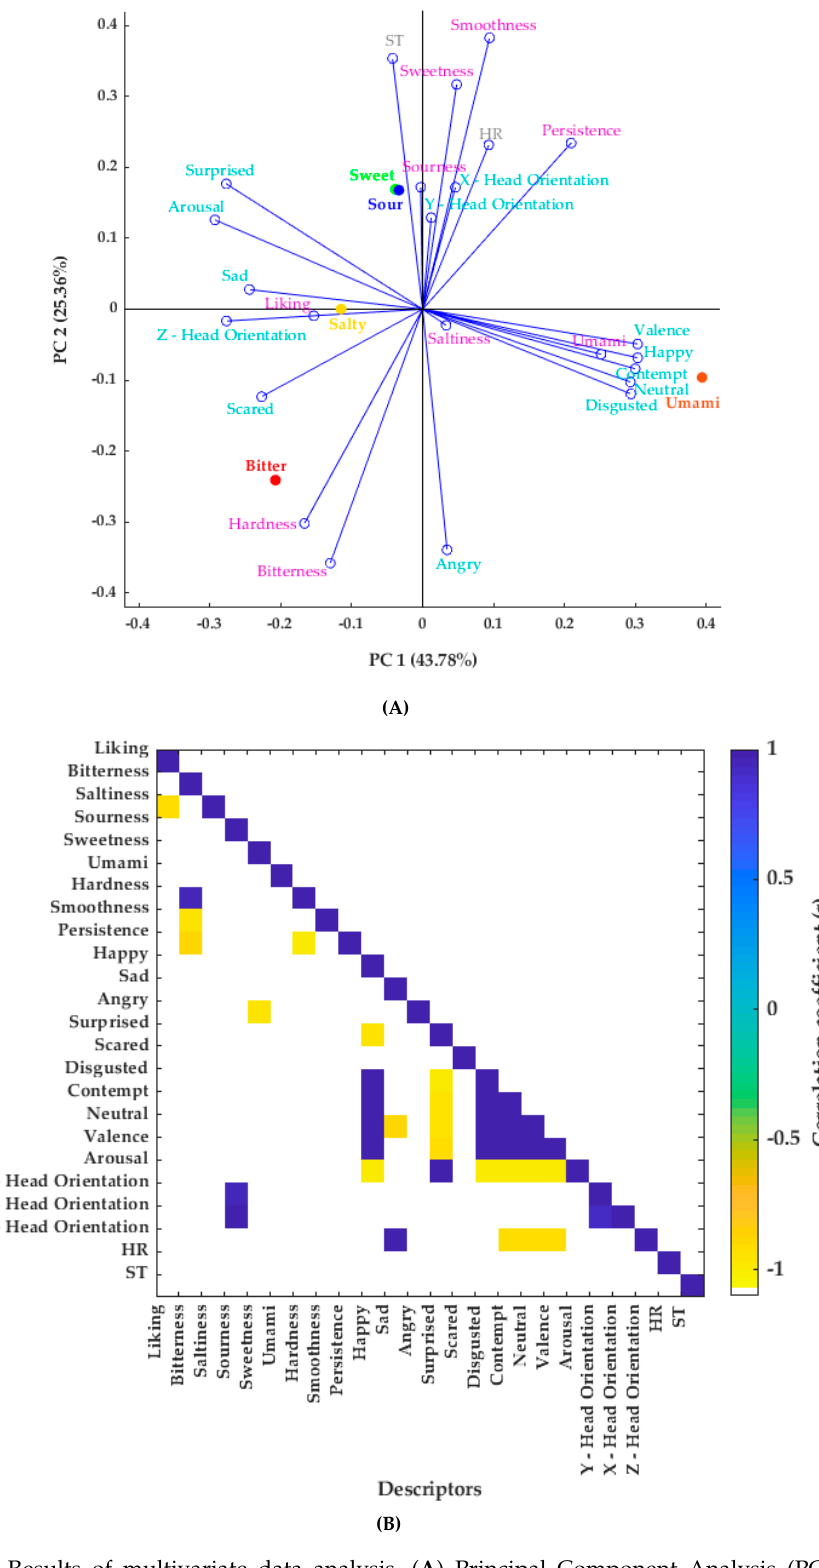
Figure 1. Results of multivariate data analysis. ( A ) Principal Component Analysis (PCA) for FaceReader™, physiological, and sensory parameters of chocolate tasting session, ( B ) Correlation matrix obtained from standardized codes. Only significant correlations ( p < 0.05) are shown in the figure (HR = heart rate; ST = skin temperature). The color bar shows a minimum value of − 1 (yellow) and a maximum value of 1 (blue).